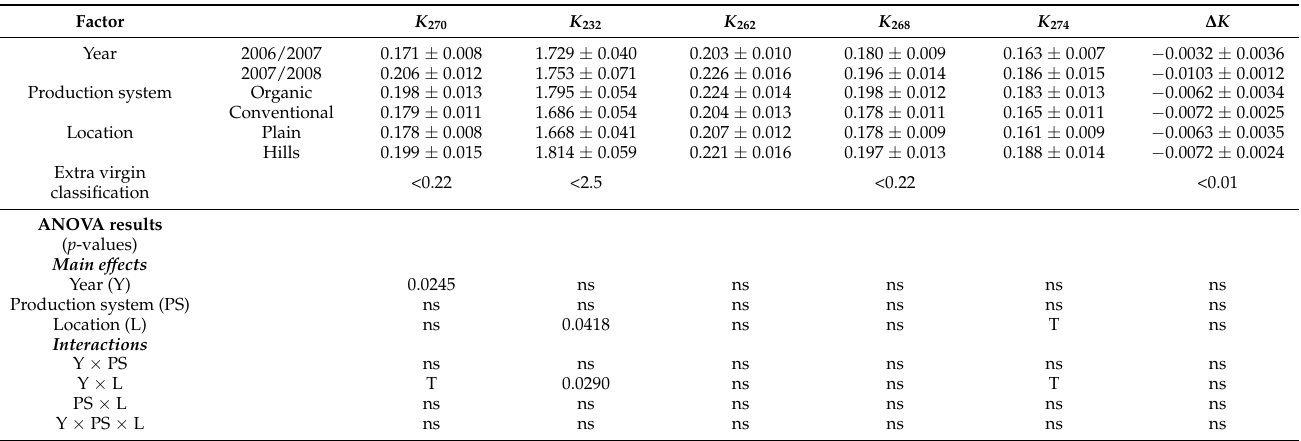
Table 5. Effect of, and interaction between (a) year (2007 or 2008), (b) production system (organic or conventional) and (c) location (plain or foothills) on oxidation related parameters ( K 270 , K 232 , K 262 , K 268 , K 274 and ∆ K ) in olive oil.